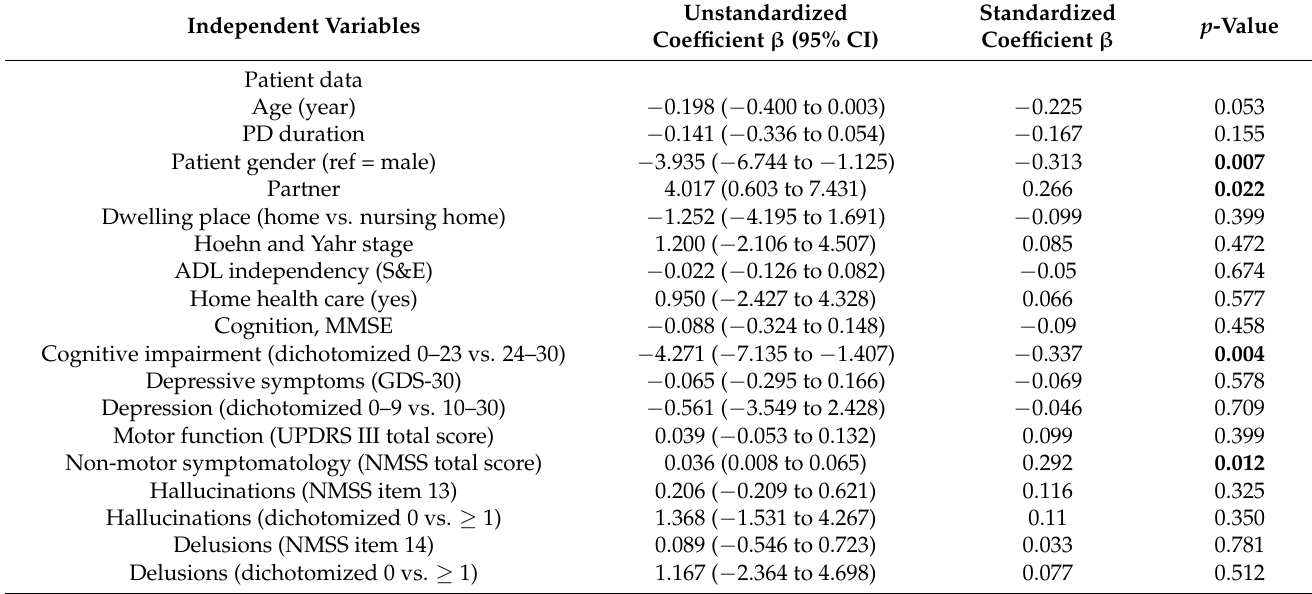
Table 2. Simple linear regression analyses with APPLIQue as the dependent variable, n = 74.